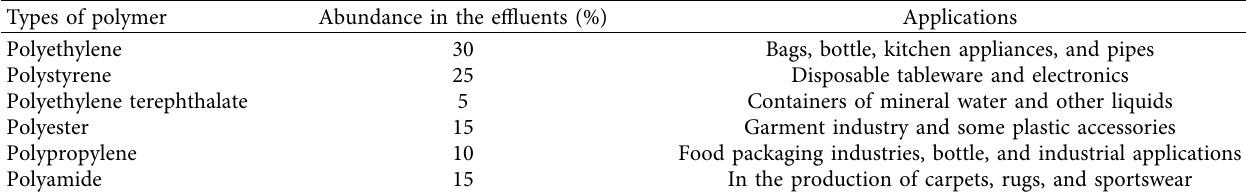
Table 2: Spectroscopy results for microplastic particles existing in the